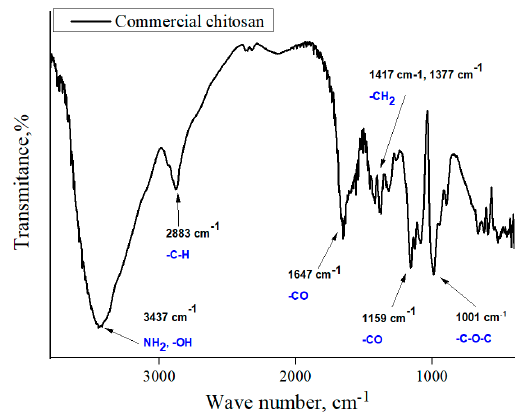
Figure 2. FTIR spectrum of commercial chitosan.